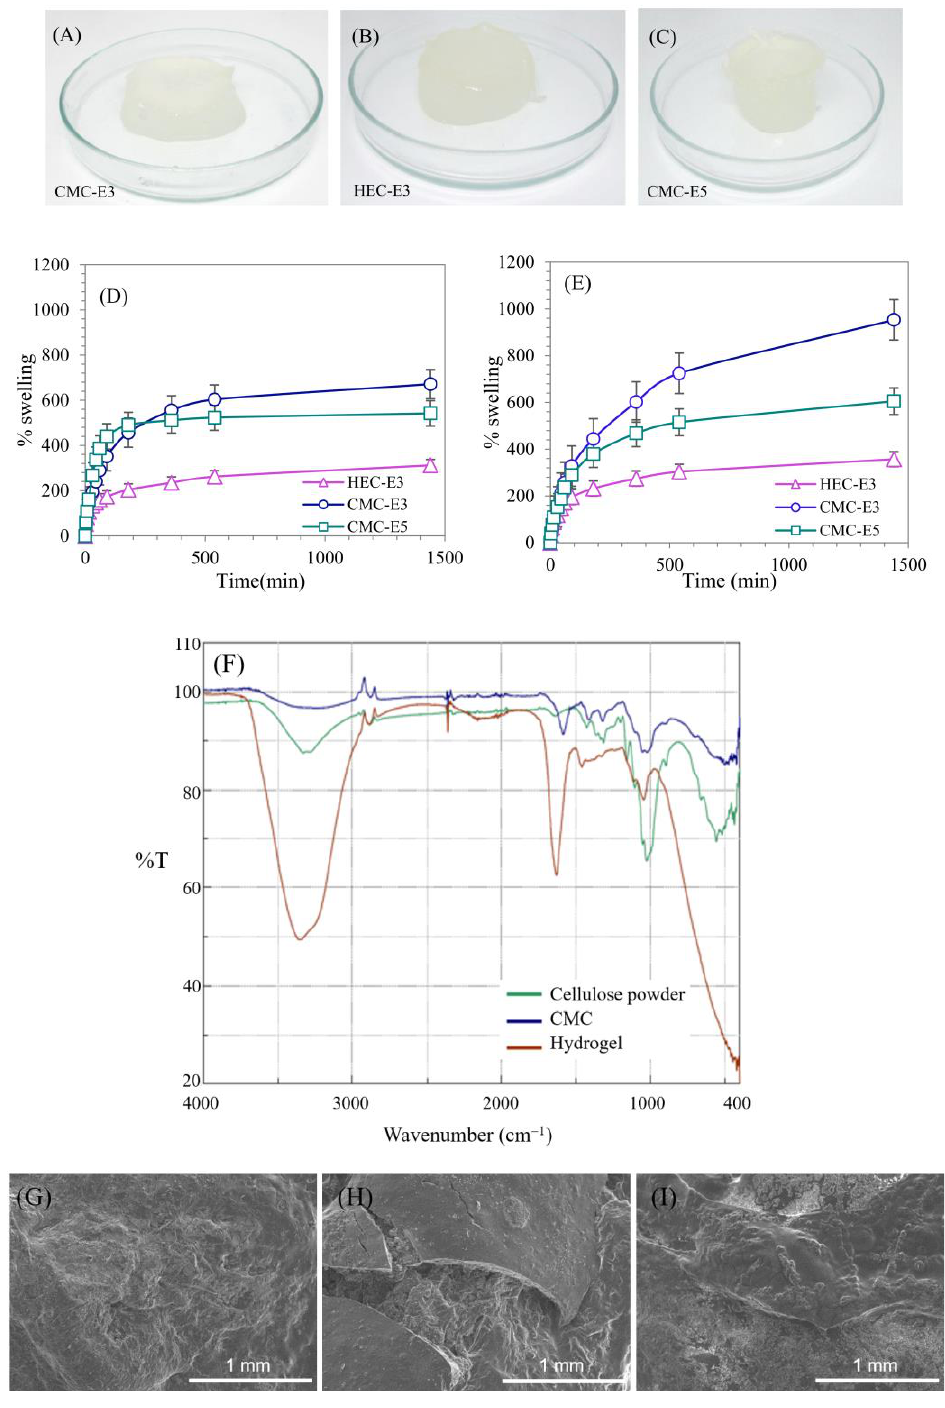
Figure 4. ( A ) Hydrogel CMC-E3, ( B ) Hydrogel HEC-E3, ( C ) Hydrogel CMC-E5 and swelling per- centage of the hydrogels ( D ) at 25 °C for 24 h, and ( E ) at 35 °C for 24 h; ( F ) FTIR spectra of CMC-E3 hydrogel, CMC and cellulose powder; scanning electron microscopic images of hydrogels ( G ) CMC- E3, ( H ) HEC-E3 and ( I ) CMC-E5.